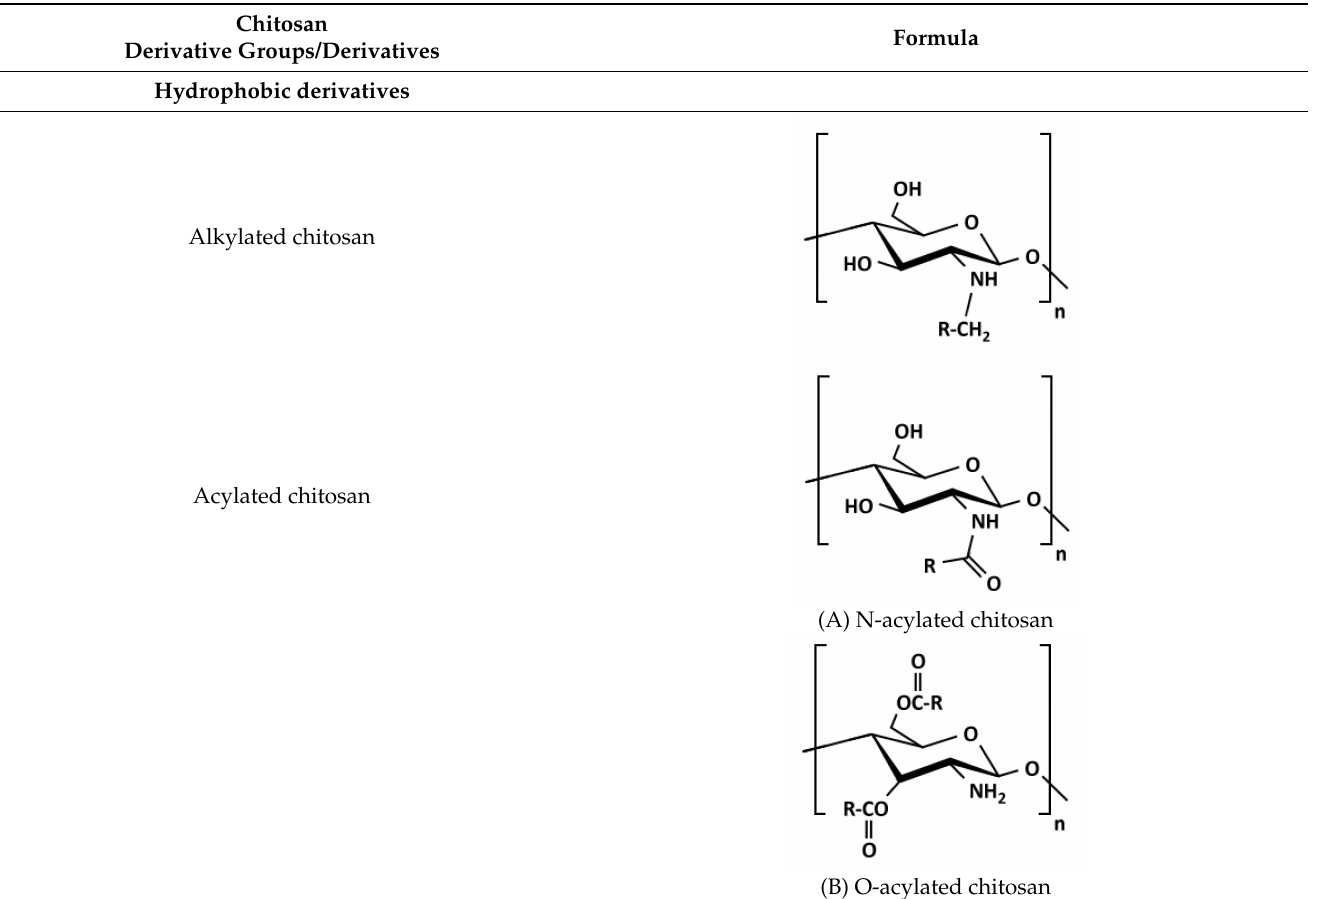
Table 1. Groups of modified chitosan and structures of particular